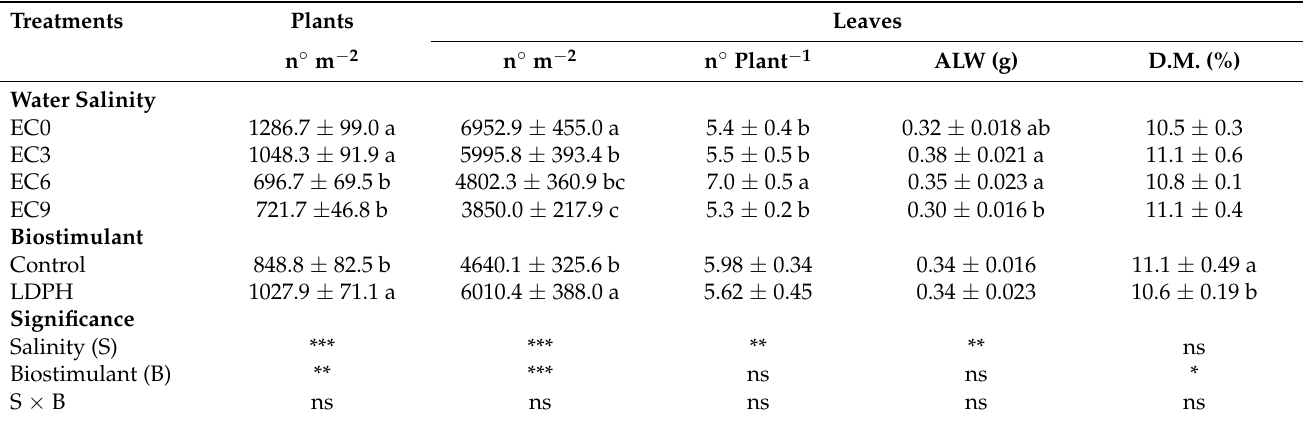
Table 2. Effects of water salinity and biostimulant applications on the number of plants and leaves per square meter, number of leaves per plant, average leaf weight (ALW; g), and leaves dry matter percentage (%) of spinach at harvest. Values are presented as means ±